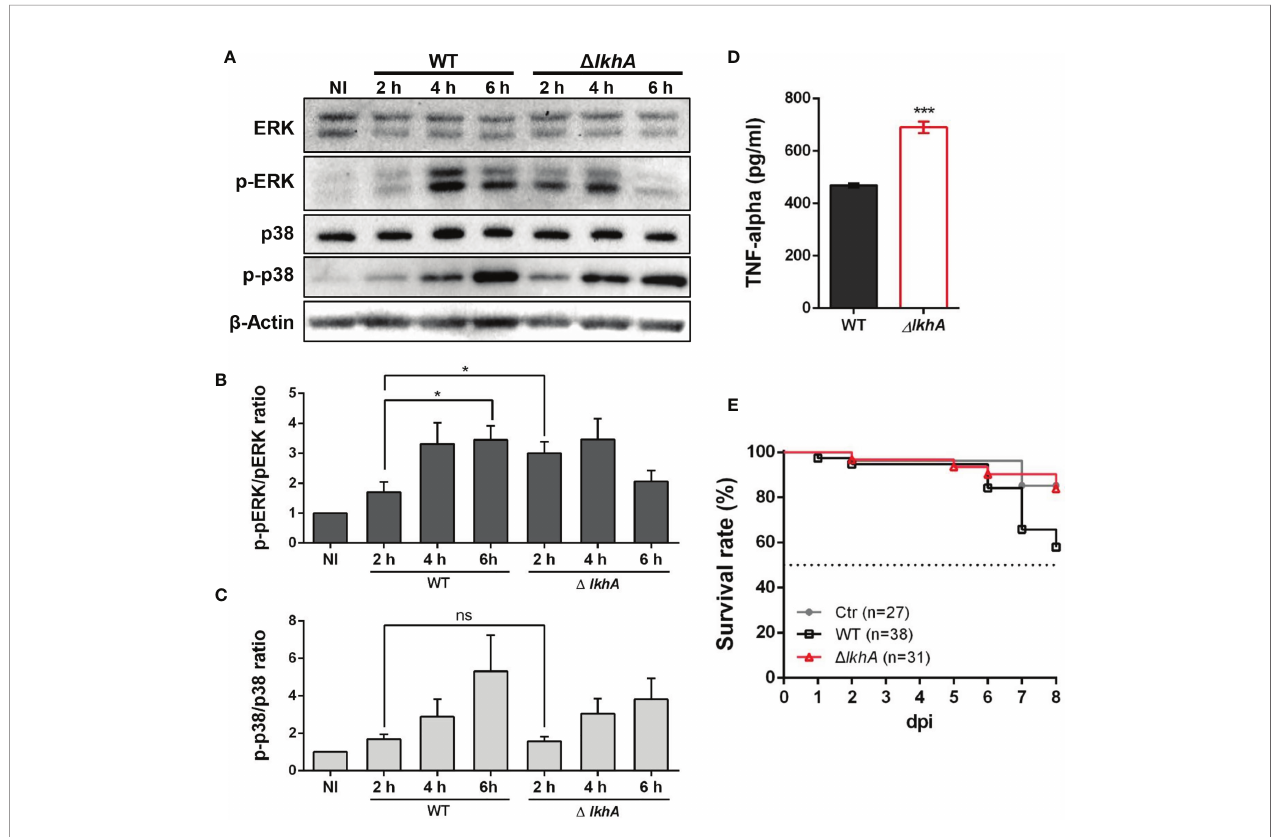
FIGURE 7 | Effect of MAPK phosphorylation and cytokine release from alveolar macrophages treated with A fl khA -null conidia. MH-S cells were simulated with 10- fold of WT and D A fl khA conidia and then incubated for the indicated time points. (A) Phosphorylation of ERK and p38 after stimulation of MH-S cells with conidia was analyzed by western blotting. The level of phosphorylation was quanti fi ed after normalization to the levels of total ERK (B) or p38 (C) using ImageJ software. *P < 0.05. ns, not signi fi cant. (D) Release of TNF- a . MH-S cells were challenged with 10-fold WT and D A fl khA conidia. The release of TNF- a was measured by ELISA 6 hrs after infection. ***P < 0.001. (E) Virulence of A. fumigatus D A fl khA in T cell-de fi cient zebra fi sh larvae ( foxn1 morphant). Conidia diluted in fl uorescence dye were injected at 3 dpf (0 dpi). Survival was monitored at > 8 dpi. Ctr represents the control. Data are mean